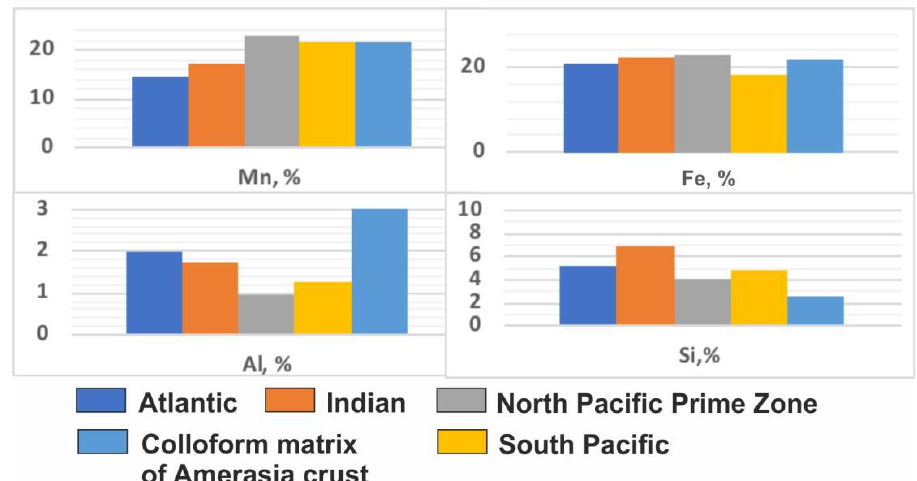
Figure 5. Chemical composition of the FeMn mineral association of Arctic crusts from SEM/EDS in wt % with crusts from the Atlantic, Indian, and Pacific oceans in wt % (PCZ, Pacific Prime Crust Zone) (comparison data from [1]).